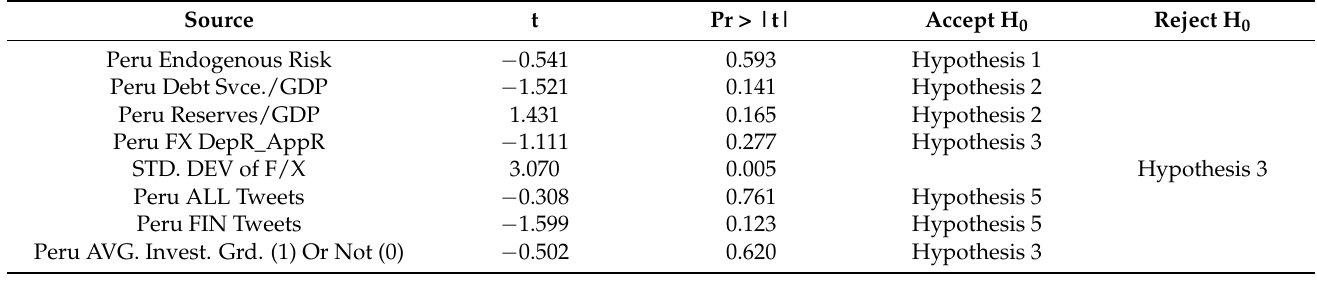
Table 10. Model parameters for Peru.